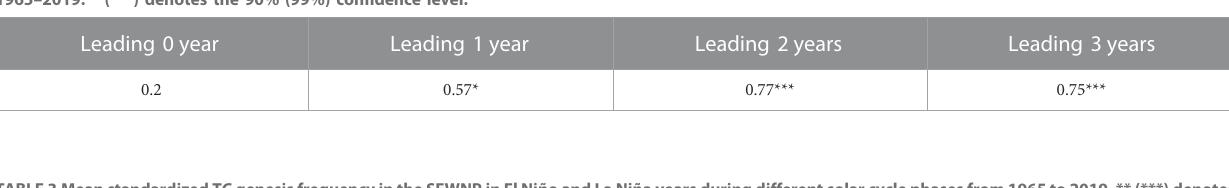
TABLE 2 Correlation coef fi cients of TC genesis frequency in the SEWNP with the SSN index in the leading 0 – 3 years on the decadal time scale in JJASON during 1965 – 2019. * (***) denotes the 90% (99%) con fi dence level.